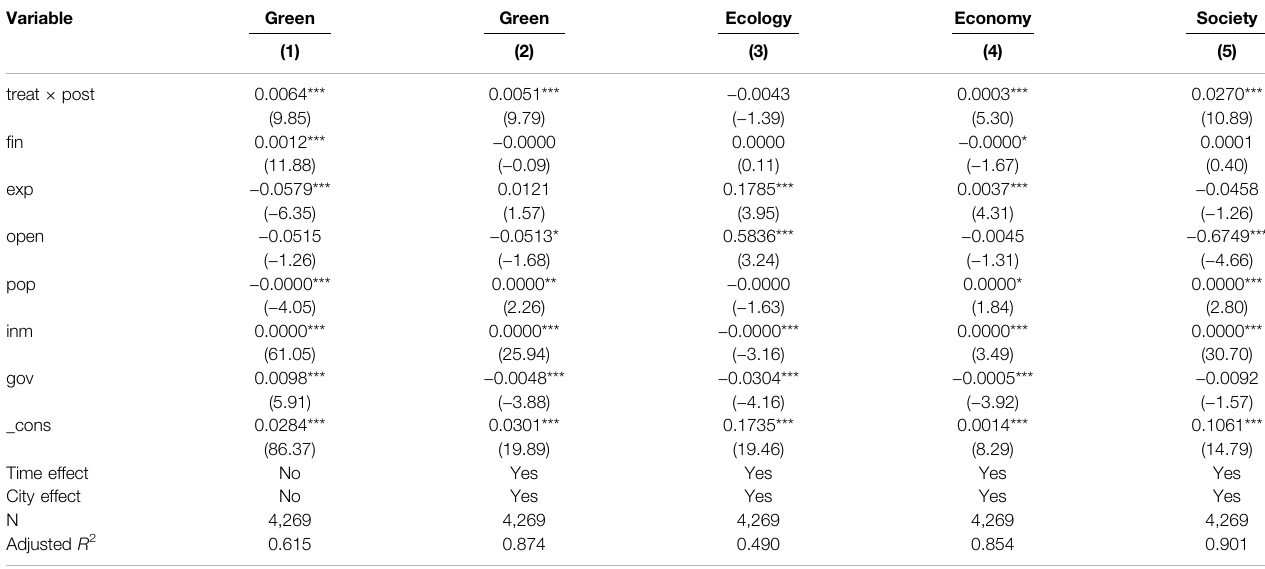
TABLE 4 | Benchmark regression test results. Variable